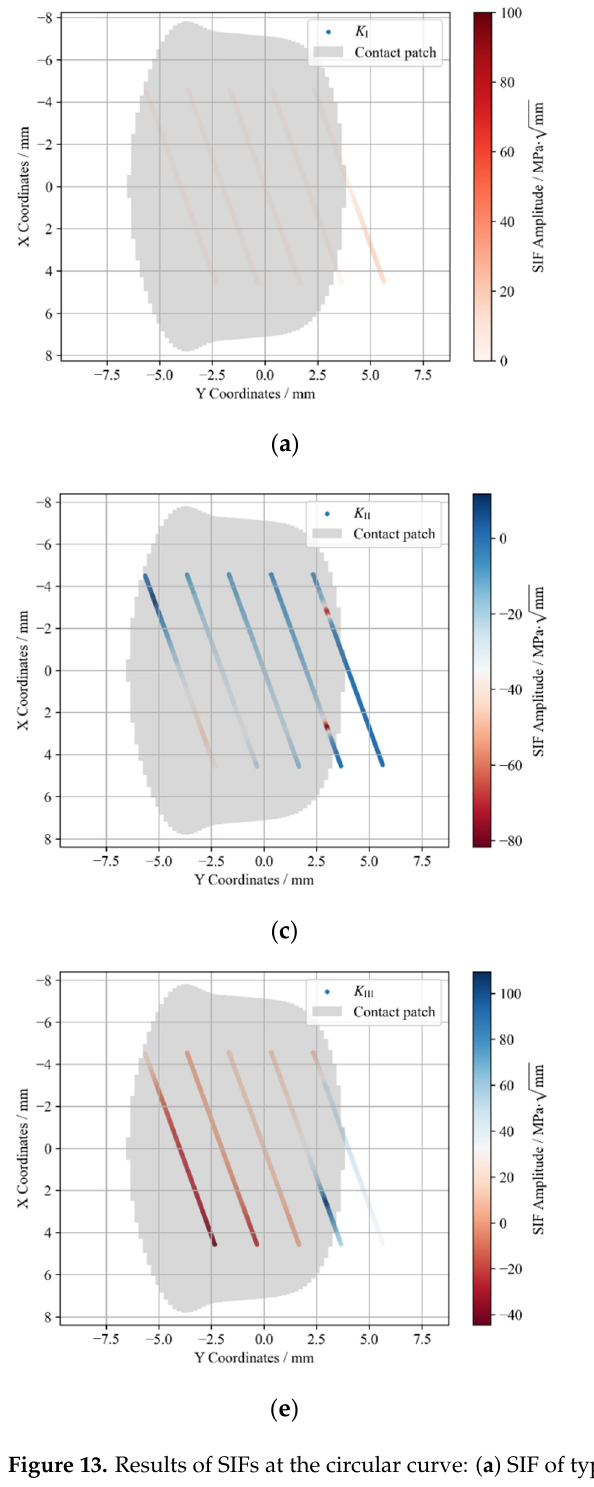
( f ) Figure 12. Results of SIFs at the transition curve: ( a ) SIF of type I cracks without the grinding marks; ( b ) SIF of type I cracks with the grinding marks; ( c ) SIF of type II cracks without the grinding marks; ( d ) SIF of type II cracks with the grinding marks; ( e ) SIF of type III cracks without the grinding marks; ( f ) SIF of type III cracks with the grinding marks. 4.3.3. Circular Curve It can be seen from Figure 13a,b that the value of the SIF in the circular curve is much higher than that in a straight line or a transition curve. In terms of distribution state, it is also clear that the adjacent contact patch is prone to crack propagation. For the model without grinding marks, the maximum value of the SIF of type I is 15.05 MPa/mm 0.5 . For the model with grinding marks, the SIF is high in the intersection area of grinding marks and the cracks. The maximum value of type I SIF reaches 56.43 MPa/mm 0.5 , indicating that poor grinding works easily lead to the rapid progress of type I cracks. For type II crack propagation in the circular curve section, it can be seen from Figure 13c,d that the K II value is mainly distributed on the contact surfaces of the wheel and rail. For the condition without grinding marks, the maximum value is 11.73 MPa/mm 0.5 . For the state with grinding marks, a higher value appears in the intersectional area of grinding marks and cracks. The overall maximum value is 65.36